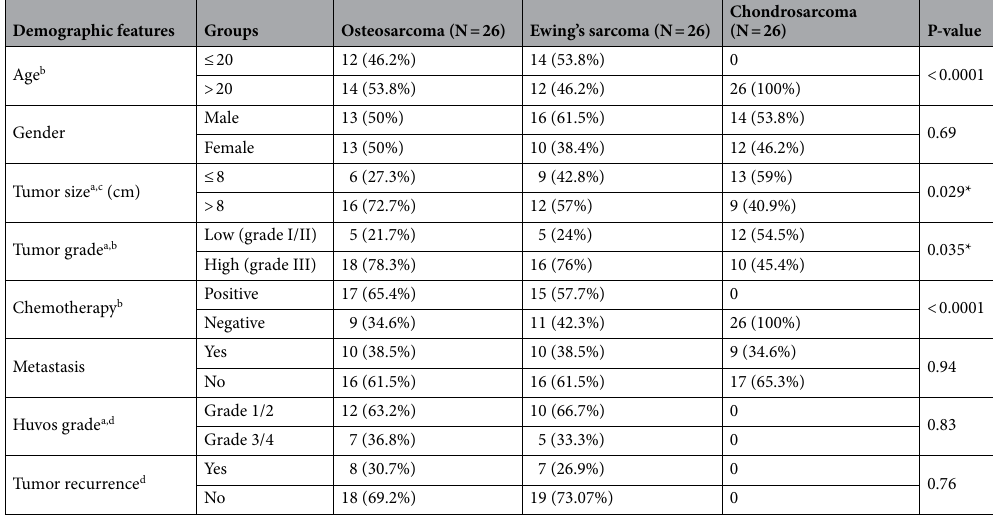
Table 1. The clinic- pathological features of patients with malignant bone tumors. a Number of patients with available information b The observed difference is between chondrosarcoma and the other two groups. c The observed difference is between Osteosarcoma and Chondrosarcoma. d The observed difference is between Osteosarcoma and Ewing